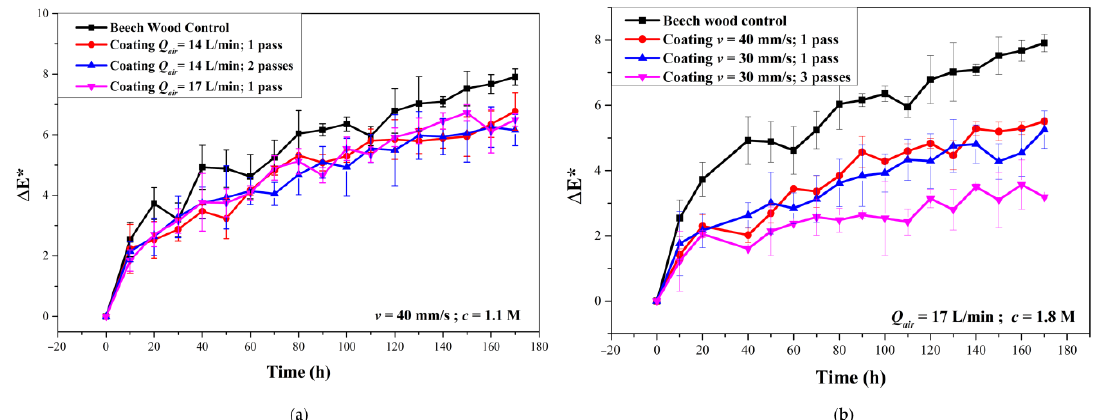
Figure 10. Change of total color Δ E* of coated and uncoated wood samples depending upon the time of irradiation ( a ) concentration of 1.1 M and ( b ) concentration of 1.8 M.